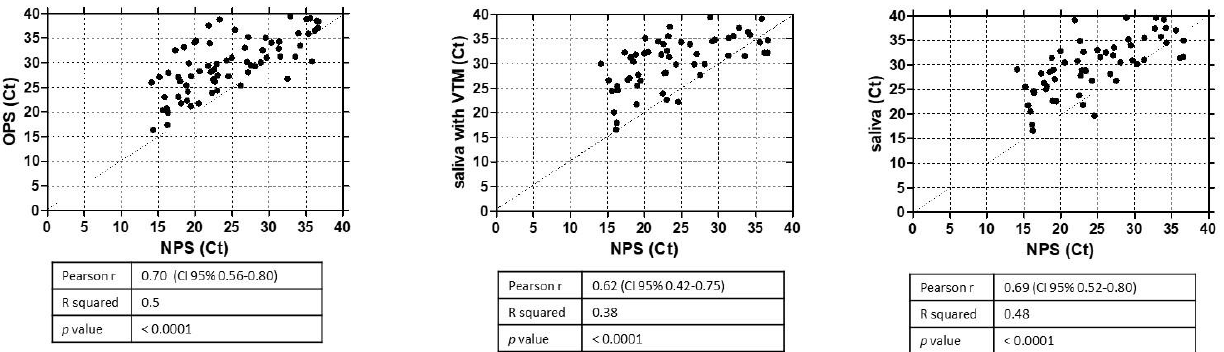
Figure 5. Comparative Ct-values scatter plots showing the correlation between NPS and different samples collection methods. Each dot represents one patient. Pearson’s correlation coefficient indicates the strength of linear dependence between the different types of samples.